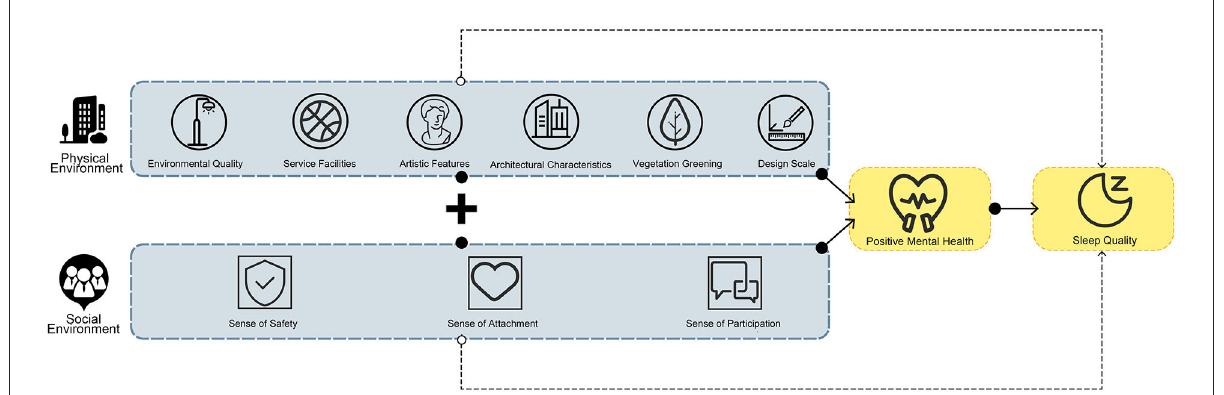
FIGURE1 Research content framework.